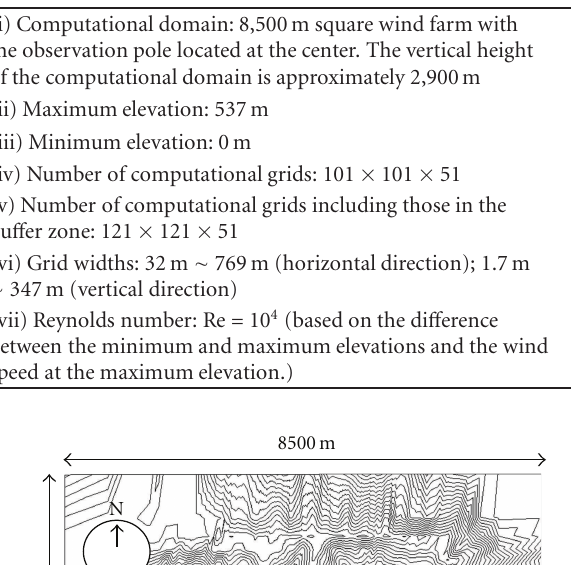
Table 2: Details of computational domain.